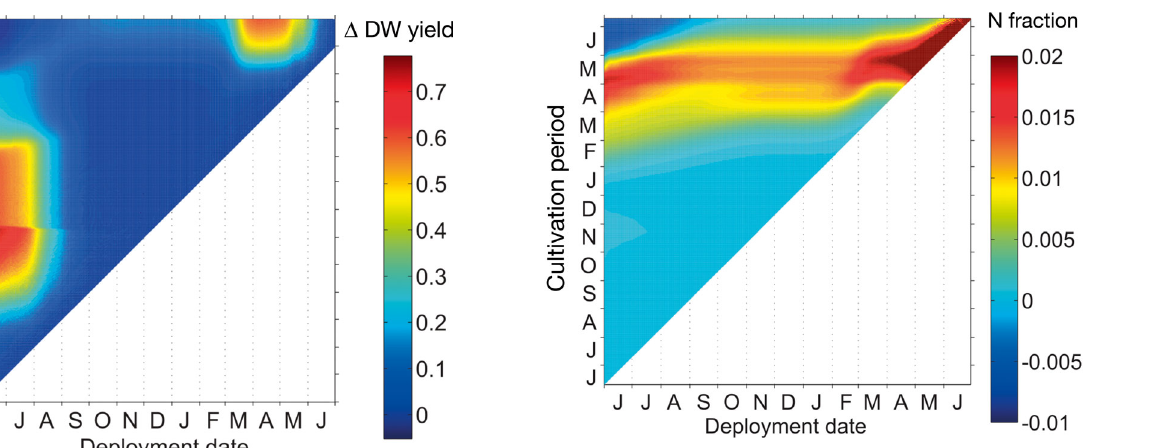
Fig. 14. Some results from Simulations D Aug,N and D Feb,N (see Table 2 for simulations). (A) Time series of accumu- lated gross fish biomass produced (black line) and simu- lated biomass of the 100 ha Saccharina latissima farm (10 4 t fresh weight [FW]) in Simulations D Aug,N (red) and D Feb,N (blue). (B) Average mean NH 4+ -N effluent (kg d −1 ) from the fish farm (black line) compared with simu- lated net uptake (kg d −1 ) of nitrogen by the entire 100 ha S. latissima farm in Simulations D Aug,N (red) and D Feb,N